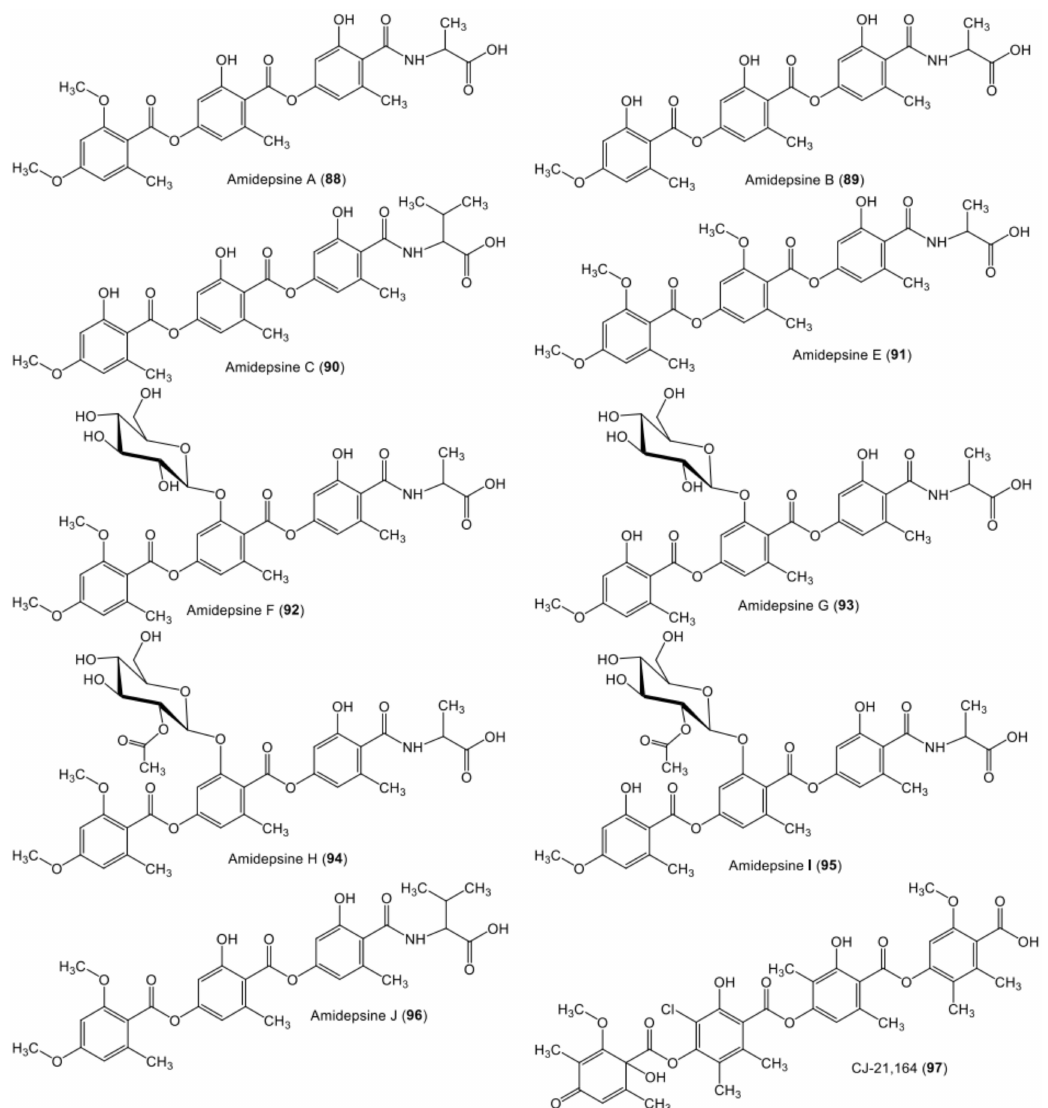
Figure 12. Chemical structures of nitrogen- and sugar-containing tri-depsides 88 – 96 and tetra-depside 97